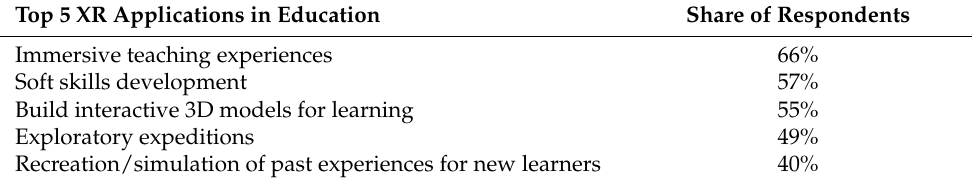
Table 4. Top 5 XR Applications in Education, source: [4].